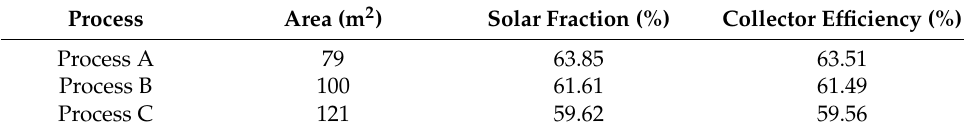
Table 3. Optimized area of each process.